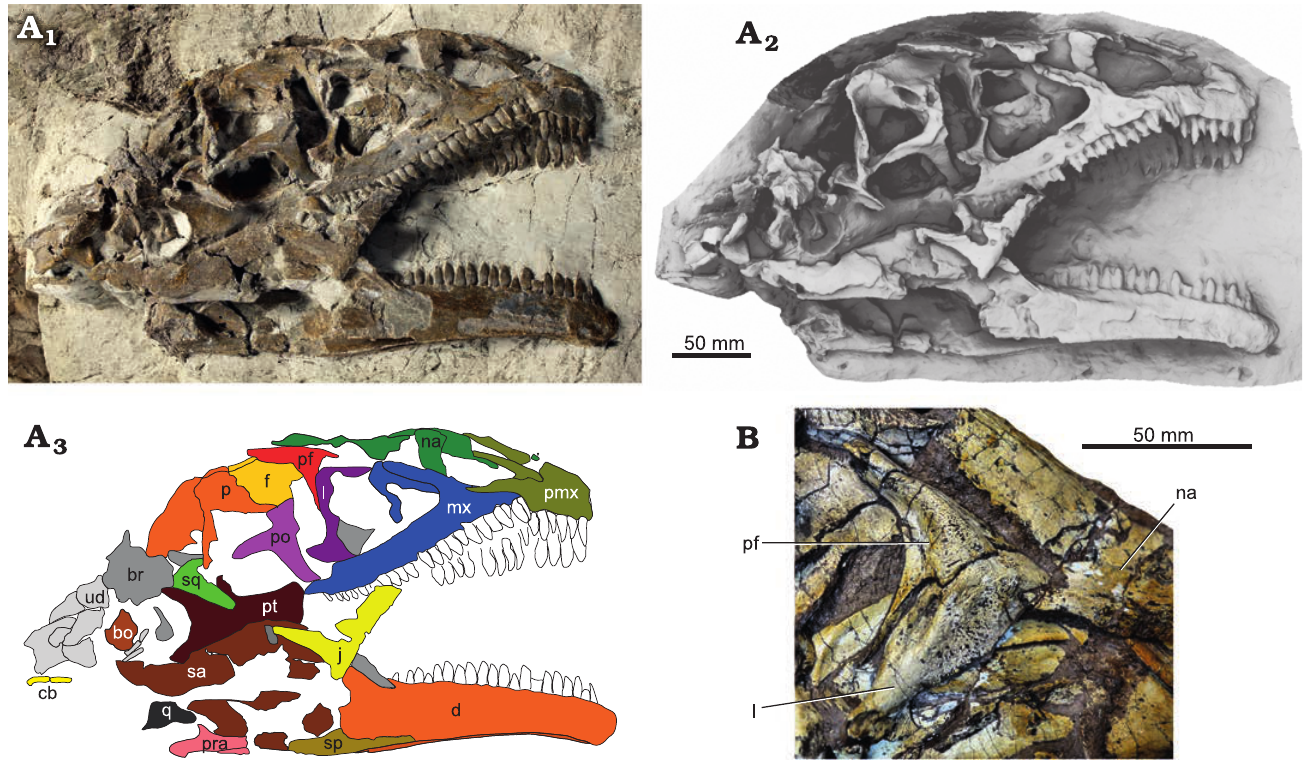
Fig. 6. A . Skull of Plateosaurus trossingensis (MSF 23) from the Triassic of Frick, Switzerland. Photograph in lateral view (A 1 ) (by Georg Oleschinski, University of Bonn, Germany); ambient occlusion of photogrammetric model (A 2 ); interpretative diagram (A 3 ). B . Detail of lacrimal and prefrontal of the right side of GPIT-PV-30784 from Trossingen. Abbreviations: bo, basioccipital; br, braincase; cb, ceratobranchial; d, dentary; f, frontal; j, jugal; l, lac - rimal; mx, maxilla; na, nasal; p, parietal; pf, prefrontal; pmx, premaxilla; po, postorbital; pra, prearticular; pt, pterygoid; q, quadrate; sa, surangular; sp, splenial; sq, squamosal; ud,